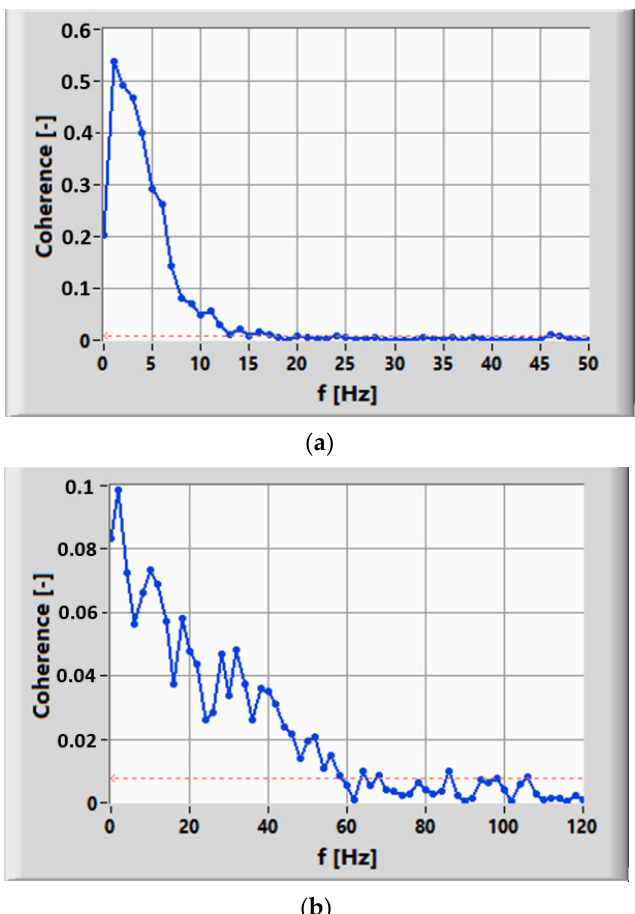
Figure 7. The coherence function in the experiments ( a ) BUB10 and ( b ) WRQ30. The standard uncertainty u ( ˆ τ 0 ) that is calculated by use phase CSDF is given by [21,38]: